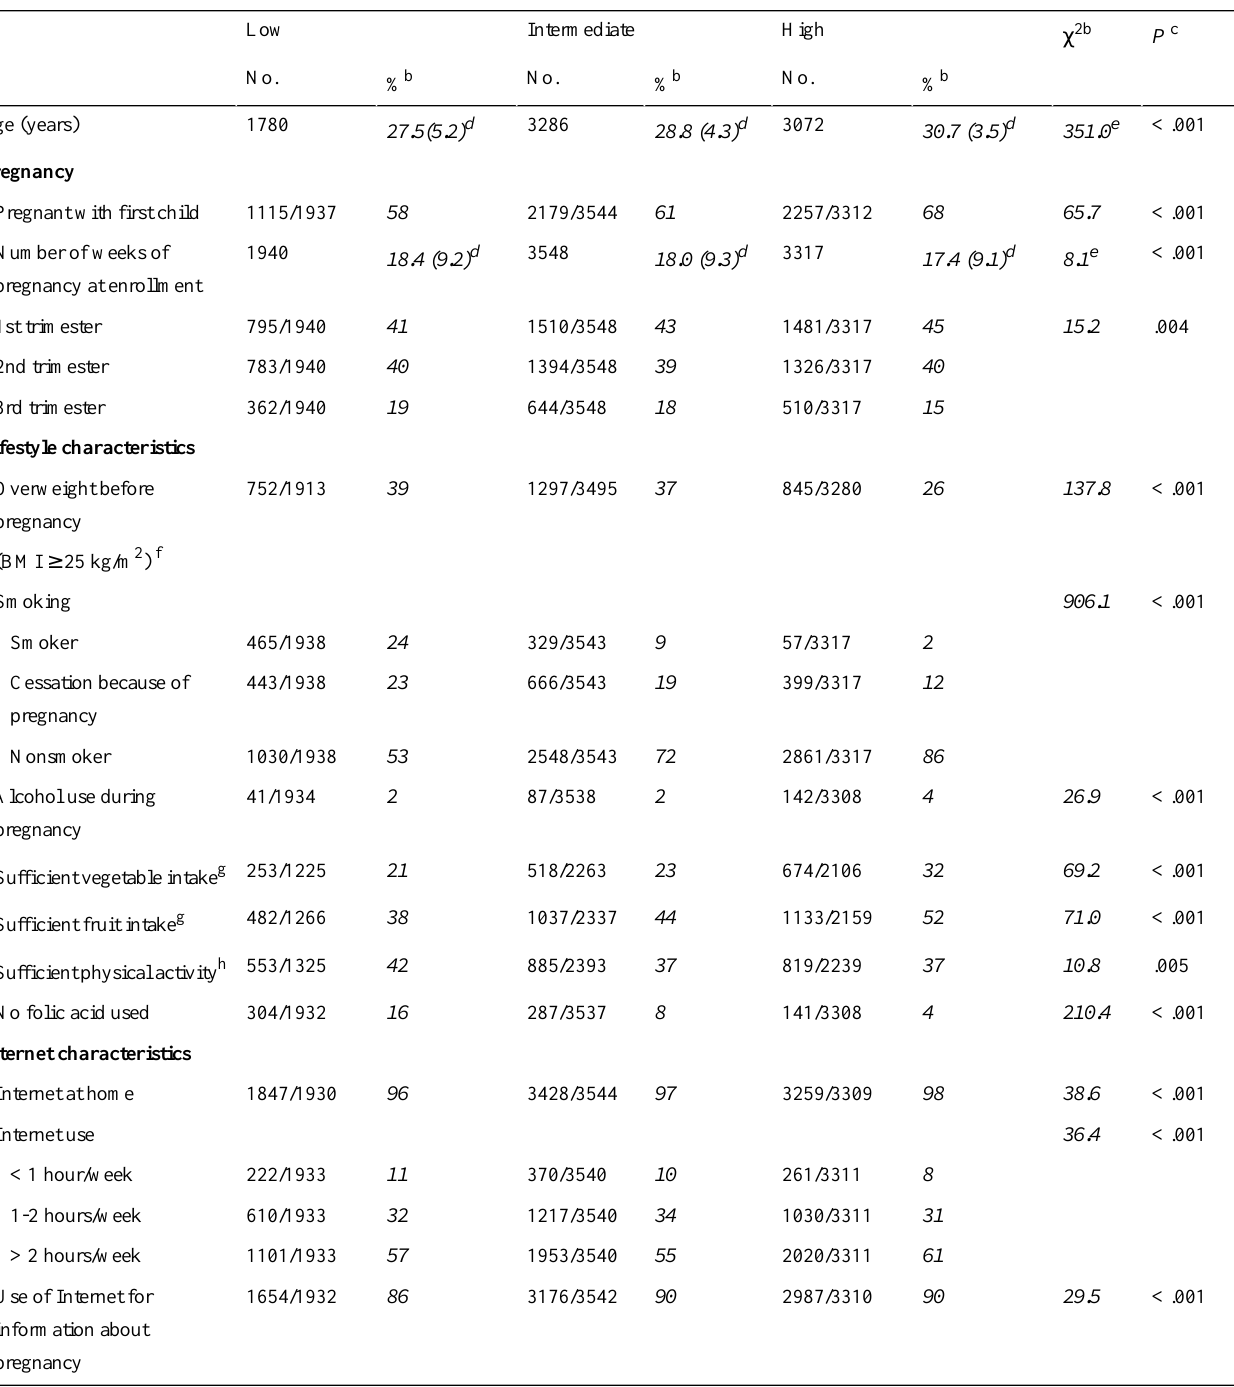
Table 3. Demographic, lifestyle, and Internet characteristics by education level a